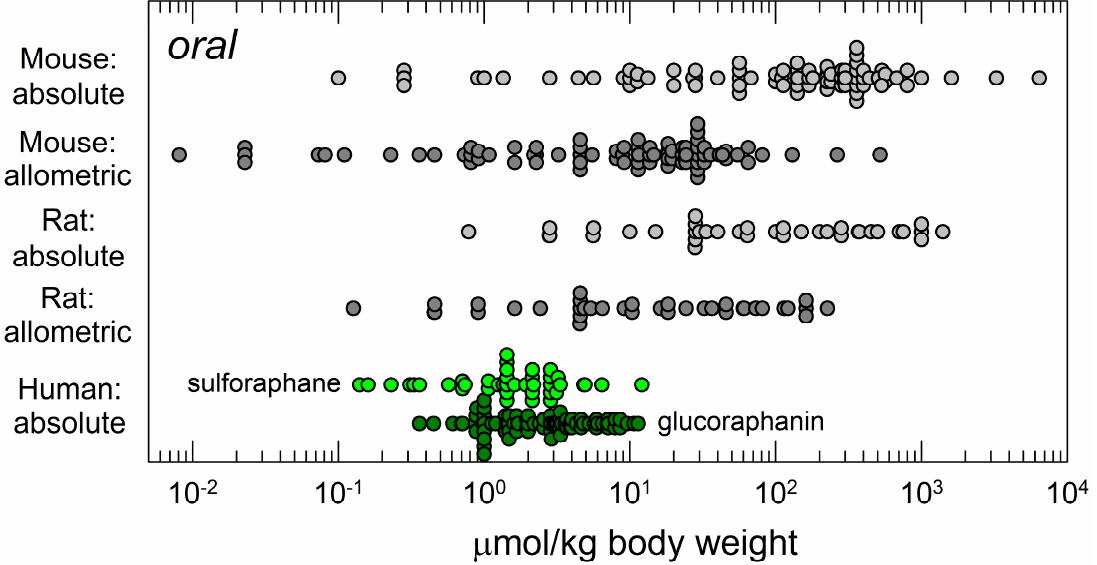
Figure 6. Comparisons of published oral doses of sulforaphane administered to mice or rats and sulforaphane (tablets or sulforaphane-rich broccoli preparations) or glucoraphanin-rich broccoli preparations administered to humans. The allometric scaling of the murine doses uses the correction factor of 0.081 and those for rat doses 0.162 [145]. Human doses were based on an estimate of 70 kg body weights in each study.